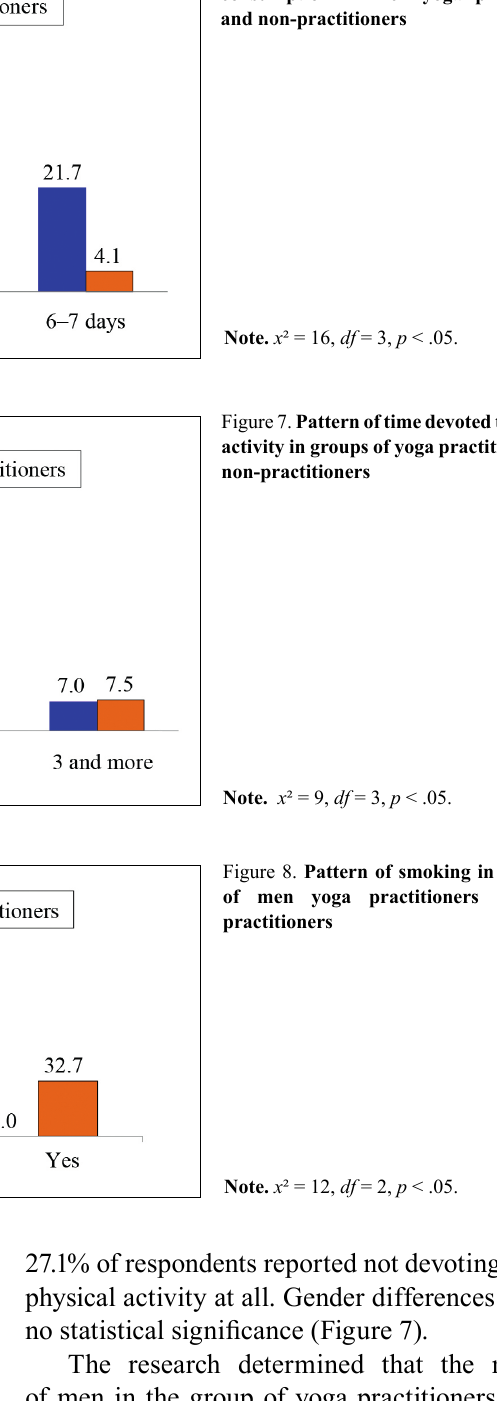
Figure 6. Pattern of cereals or grain consumption in men yoga practitioners and non-practitioners